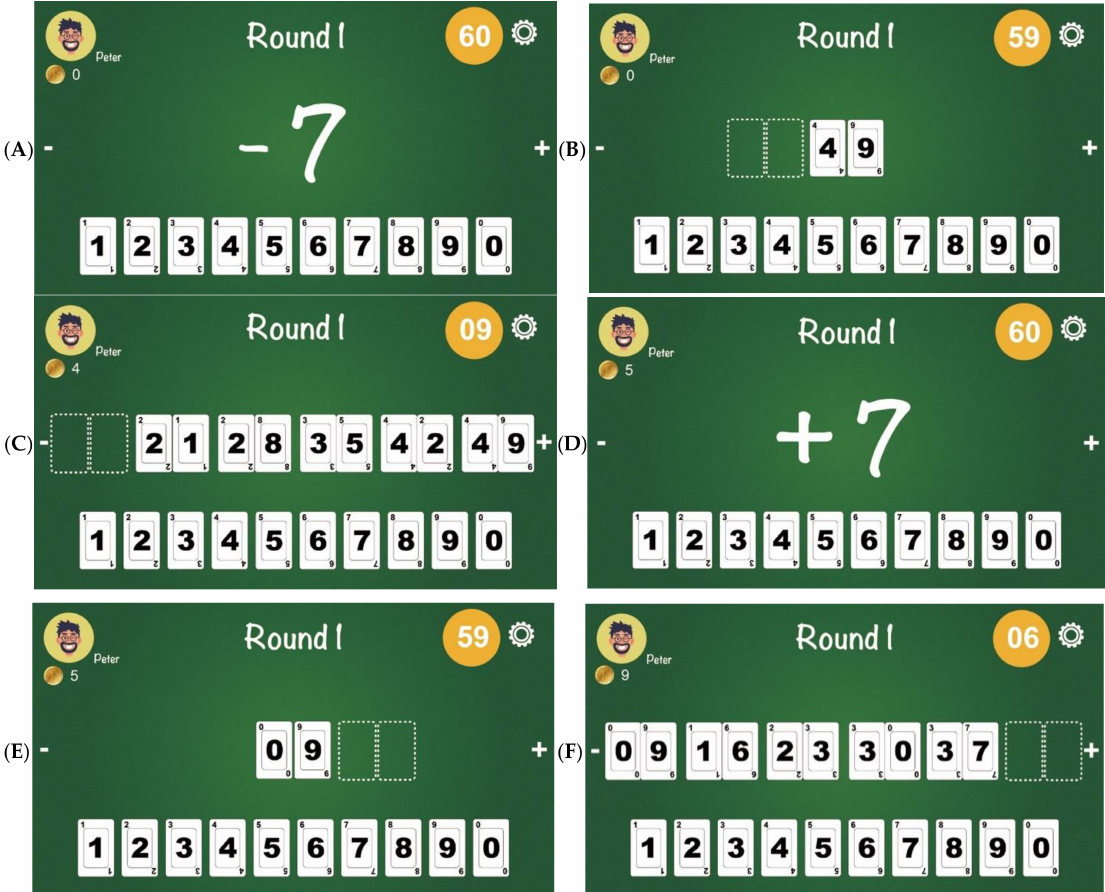
Figure 3. Cleverbrain game design—the game user interface and game process. ( A ) For each round, there are 2 sets of mental arithmetic questions. The 1st set is the serial subtraction task, and the 2nd set is the serial addition task. Before the game starts, the screen shows the game rules and details in the middle (for example, this set is Minus 7, a serial subtraction task). ( B ) After the game is started, a pair of random cards is distributed in the middle area by the internal system. This is the starting number. Players follow this number to play. They select the card in the bottom area and move it to the (left side) targeted area (dotted-line area). ( C ) Players keep answering serially (left side) until six pairs of cards have been played. ( D ) After completing the 1st set, the 2nd set then starts afterward. The screen shows the game details in the middle (for example, this set is Add 7, the serial addition task). ( E ) After the game is started, a pair of random cards is distributed to the middle area by the internal system. This is the starting number. Players follow this number to play. They select the card in the bottom area and move it to the (right side) targeted area (dotted-line area). ( F ) Players keep answering serially (right side) until six pairs of cards have been